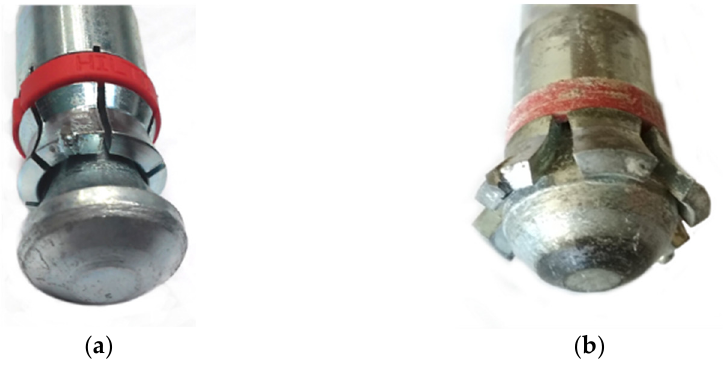
Figure 15. Self-undercut anchor: ( a ) before installation; ( b ) after use. Figure 12. Self-undercut anchor: ( a ) before installation; ( b ) after use.